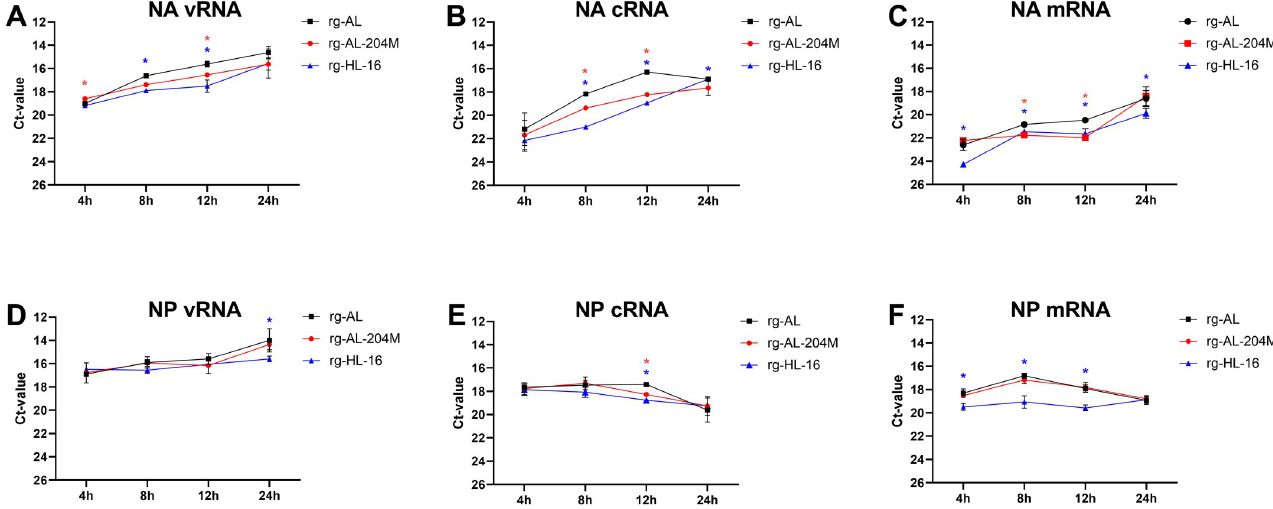
Fig 5. Quantification of NA vRNA, cRNA and mRNA in infected cells. Ct-values of strand specific RT-qPCR for detection of vRNA, cRNA and mRNA for NA (D-F) or NP (G-I) of indicated H5N1 viruses in MDCK-II cells infected with an MOI of 1 for 4, 8, 12 and 24 h. Results are shown as mean and standard deviation of two triplicate experiments. Asterisks indicate significant differences at p <